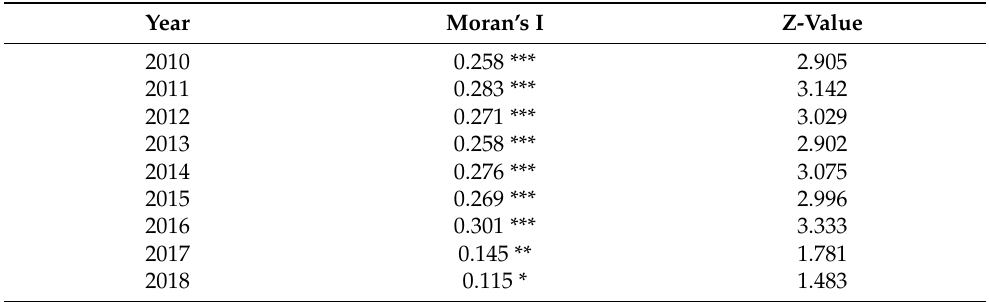
Table 6. Characteristics of the spread of digital innovation level emissions for 2010–2018.